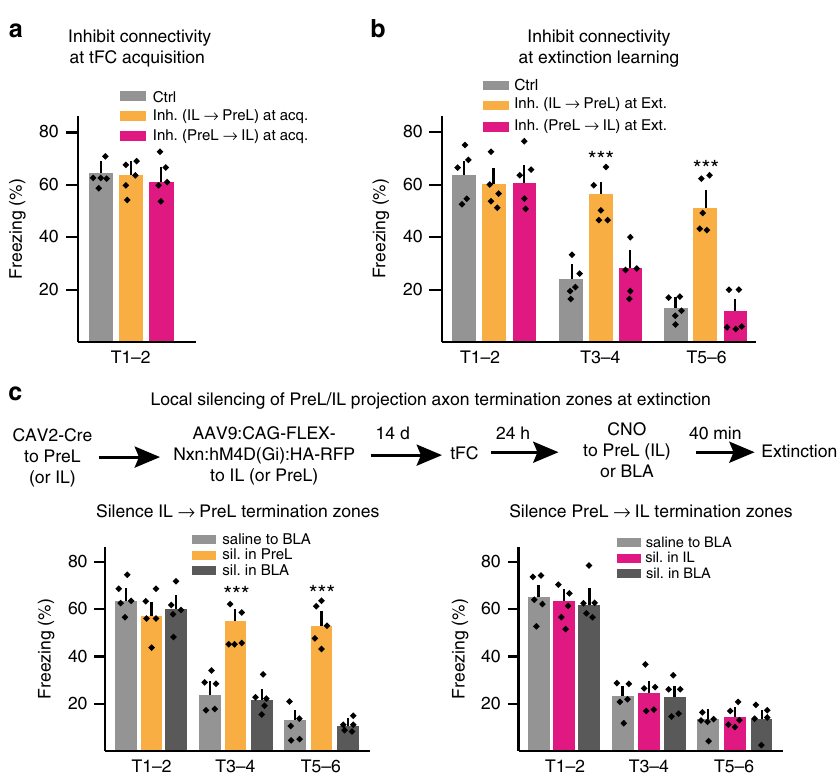
Fig. 5 IL → PreL activity required in IL driven extinction learning. a, b Impact of inhibiting activity in IL → PreL or PreL → IL projection neurons during acquisition of tFC (T1 – 2 recall values) ( a ; n = 5 each; one-way ANOVA: F (2, 12) = 0.057, P = 0.9446 ns ) or during extinction learning ( b ; n = 5 each; repeat measure two-way ANOVA: Inh. IL → PreL vs. PreL → IL, F (2, 8) = 23.22, *** P ). c Local silencing of IL → PreL or PreL → IL projecting axon collaterals in their termination zones during extinction learning. Top: schematic of experimental strategy (expression of Neurexin-inhibitory DREADDs fusion protein). Bottom: suppression of extinction learning by silencing of IL → PreL ( n = 5 each; repeat measure two-way ANOVA: Inh. Terminals in PreL vs. BLA, F (2, 8) = 58.6, *** P ), but not PreL → IL ( n = 5 each; repeat measure two-way ANOVA: Inh. Terminals in IL vs. BLA, F (2, 8) = 2.81, P = 0.119 ns ) collateral terminals in PreL (or IL), but not BLA. Error bars: SEM. Tukey ’ s post hoc; P < 0.05 ( * ), 0.001 ( ** ), 0.0001 ( ***